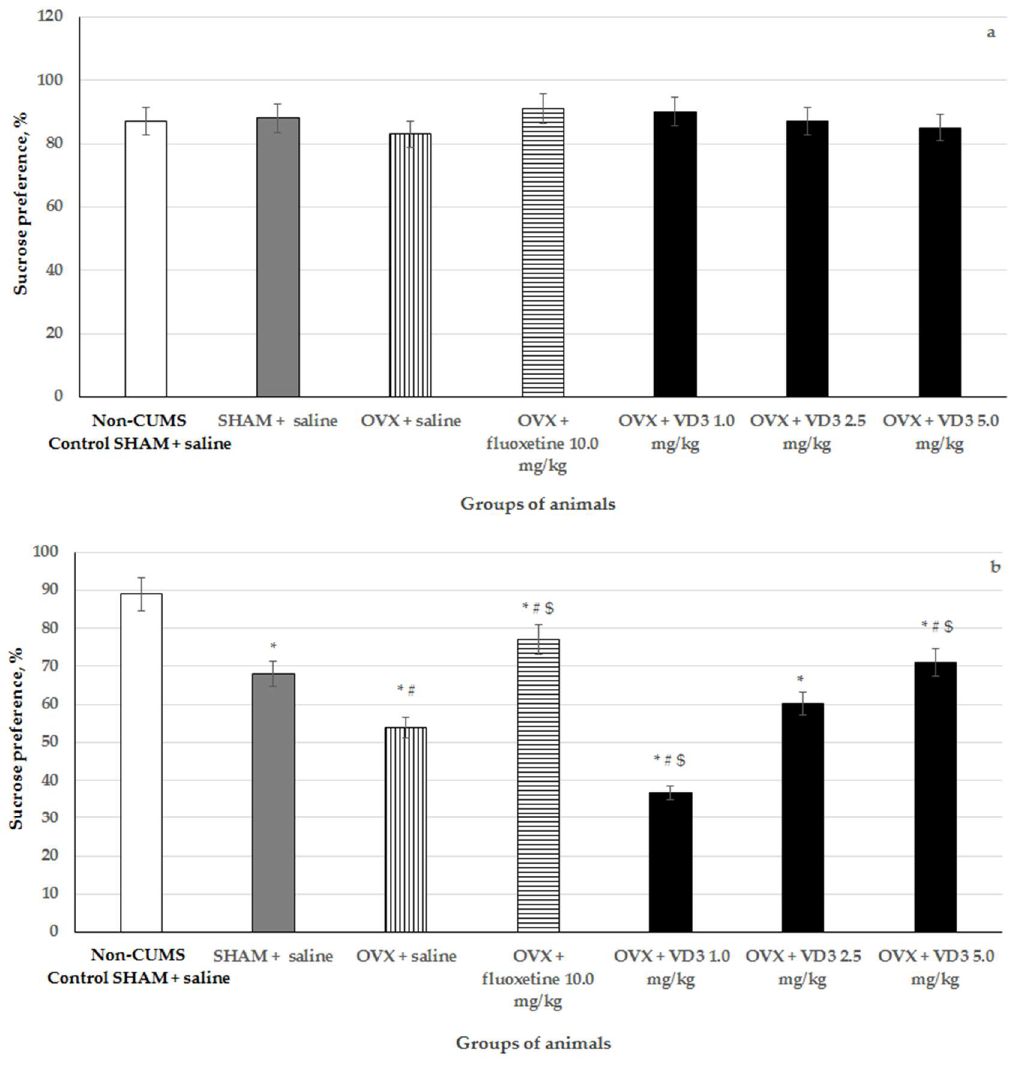
Figure 3. Effects of VD 3 administered in various doses on sucrose preference in long-term OVX rats before ( a ) and after ( b ) CUMS protocol. *— p < 0.05 versus the non-CUMS SHAM group (control group) treated with saline, #— p < 0.05 versus the SHAM group with CUMS treated with saline, $— p < 0.05 versus the long-term OVX group with CUMS treated with saline. The data are presented as the mean ± SD; n = 7 in each group.